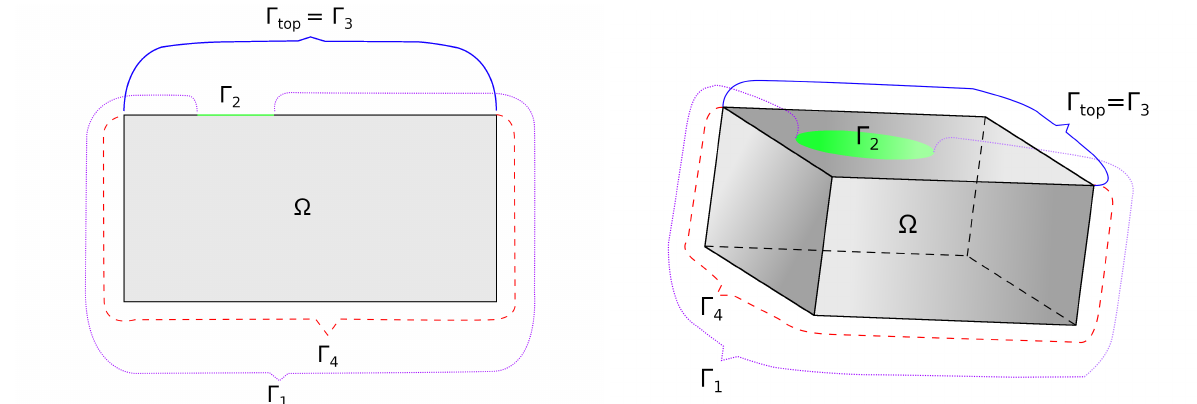
Figure 3. Schematic representation of a possible variant of the domain Ω and the boundaries. On the left is a two-dimensional case, on the right is a three-dimensional